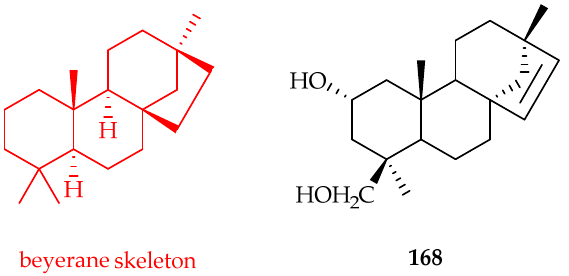
Figure 71. Structures of beyerane skeleton and aleuritopsis A 168 [109].